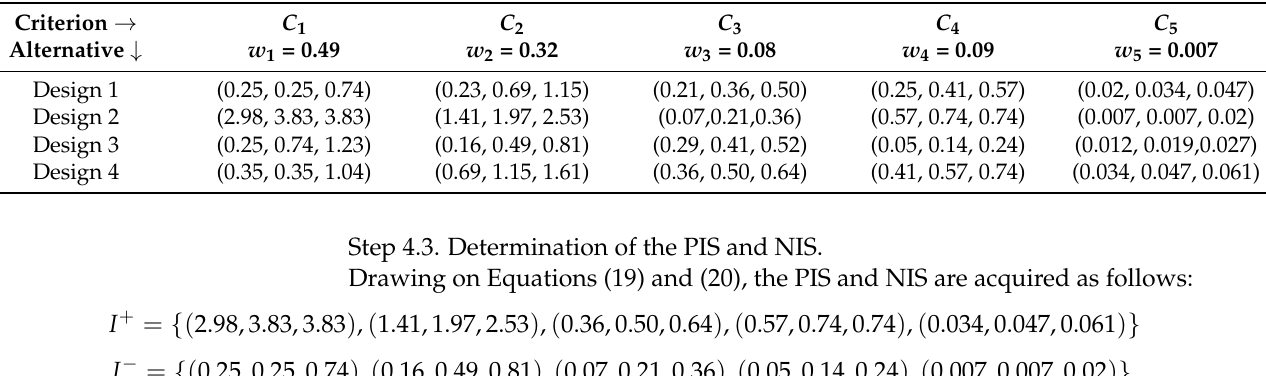
Table 5. Z-AHP weighted decision